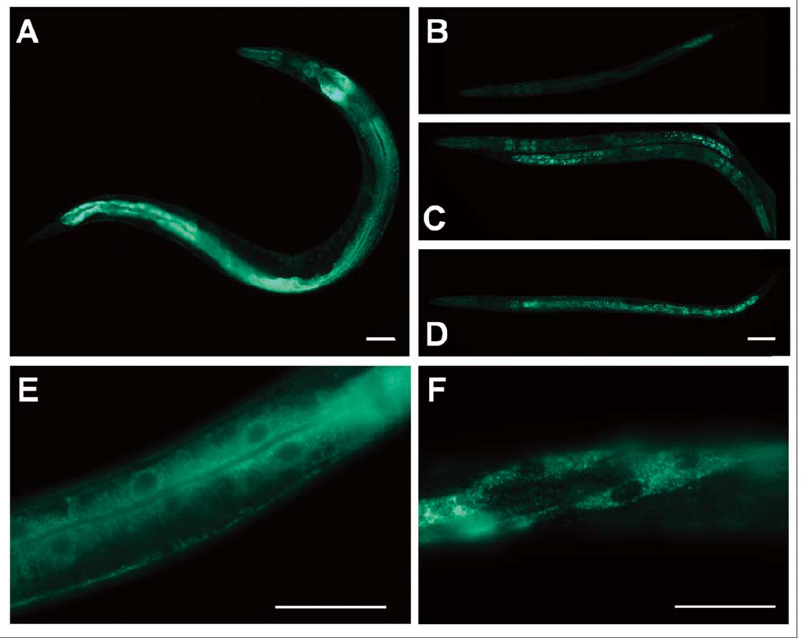
Figure 2. PDHK-2::GFP is highly expressed in starvation and dauer stages. ( A ) pdhk-2 p::PDHK-2::GFP localization in the N2 adult stage. ( B ) pdhk-2 p::PDHK-2::GFP localization in the L3 stage after good nutrition. ( C ) pdhk-2 p::PDHK-2::GFP localization in the L3 stage after 12-hour of starvation. ( D ) pdhk-2 p::PDHK-2::GFP localization in the dauer stage after 7 days of starvation. ( E ) Intestinal expression of pdhk-2 p::PDHK-2::GFP under well-fed conditions at the L4 stage. ( F ) Muscle expression of pdhk-2 p::PDHK-2::GFP in worms starved for 12-hour at the L4 stage. Scale bar: 50 m m. daf-2(e1370);pdhk-2 ( tm3086 ) (16.5 6 0.97 days, p , 0.001) double mutants and daf-7(e1372) (18.8 6 0.89 days p , 0.0001) compared to daf-2(e1370) controls (11.4 6 1.76 days; Figure 3F). This